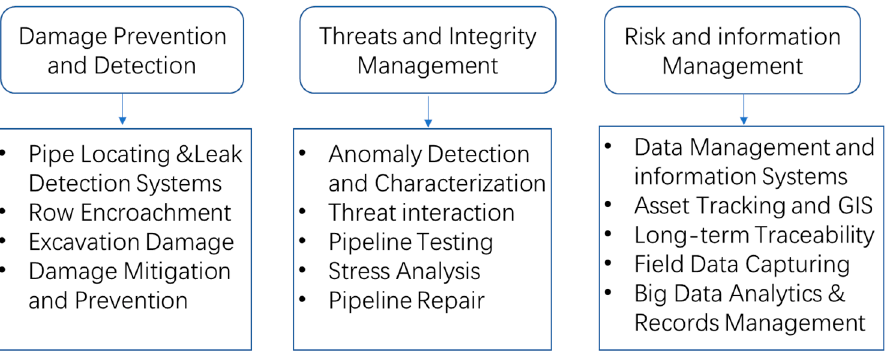
Figure 1. Technologies categories and research areas. Adapted with permission from ref. [29]. 2021 Copyright Khalid Farrag . Copyright Khalid